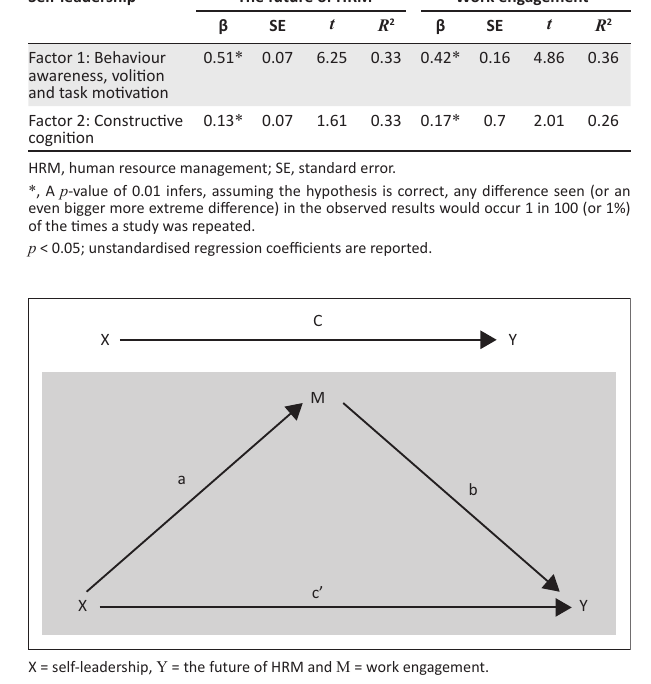
FIGURE 2 : A simple mediation